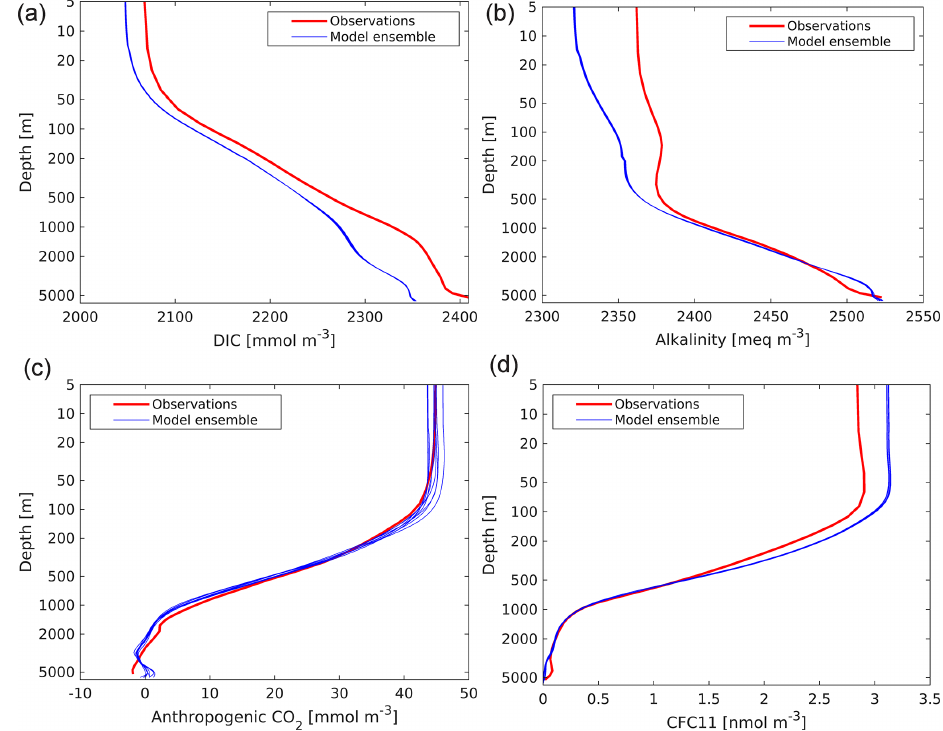
Figure 22. Observed (GLODAPv1.1; Key et al., 2004) and modelled vertical profiles of DIC ( a ; mmolCm − 3 ), alkalinity ( b ; meqm − 3 ), anthropogenic CO 2 ( c ; mmolCm − 3 ) and CFC-11 ( d ; nmolm − 3 ). GLODAPv1.1 is used here, as the time period used (the 1990s) overlaps that of observational CFC-11. Model profiles from the ensemble used in this analysis are presented individually and are geographically masked according to